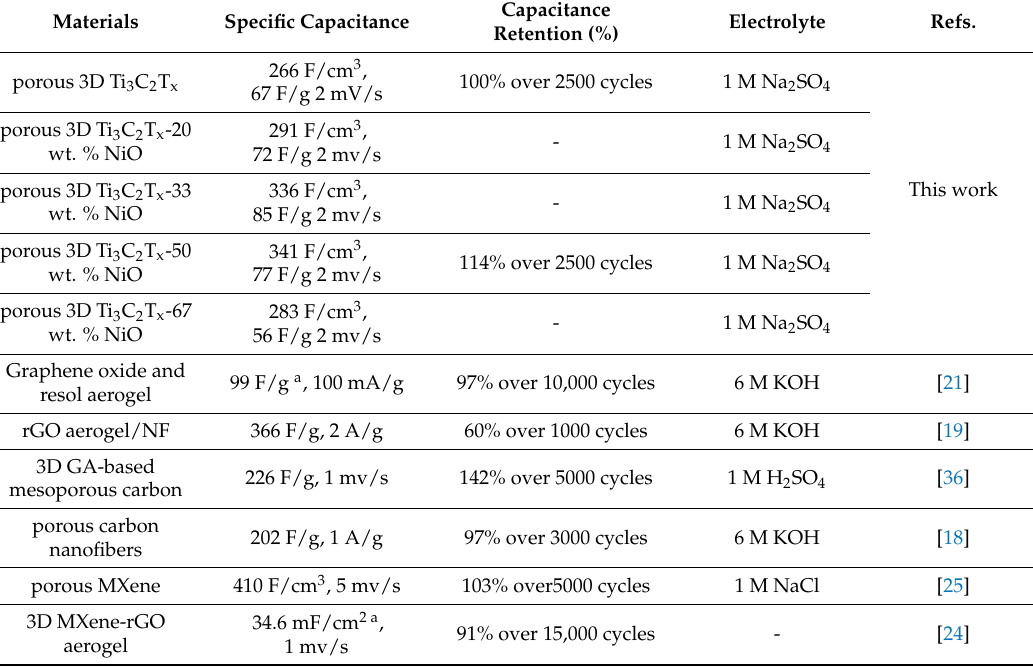
Figure 5. Cycling performance tested by galvanostatic charge-discharge conducted at 1 A/g for ( a ) pure 3D porous Ti 3 C 2 T x and ( b ) Ti 3 C 2 T x -50 wt. % NiO. Table 2. Summary of specific capacitance and cyclic stability obtained for formulated porous 3D Ti 3 C 2 Tx and Ti 3 C 2 T x -NiO compared to the values reported in other literature.